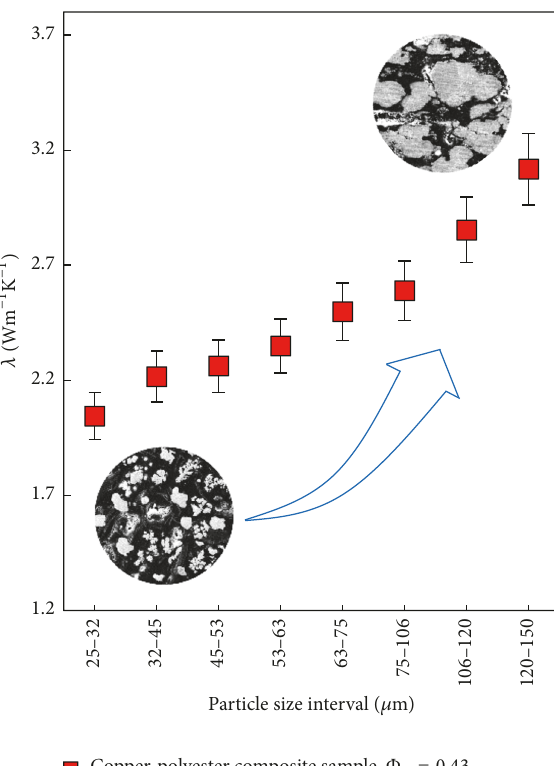
Figure 8: Stress-strain curves of the composites with various Cu